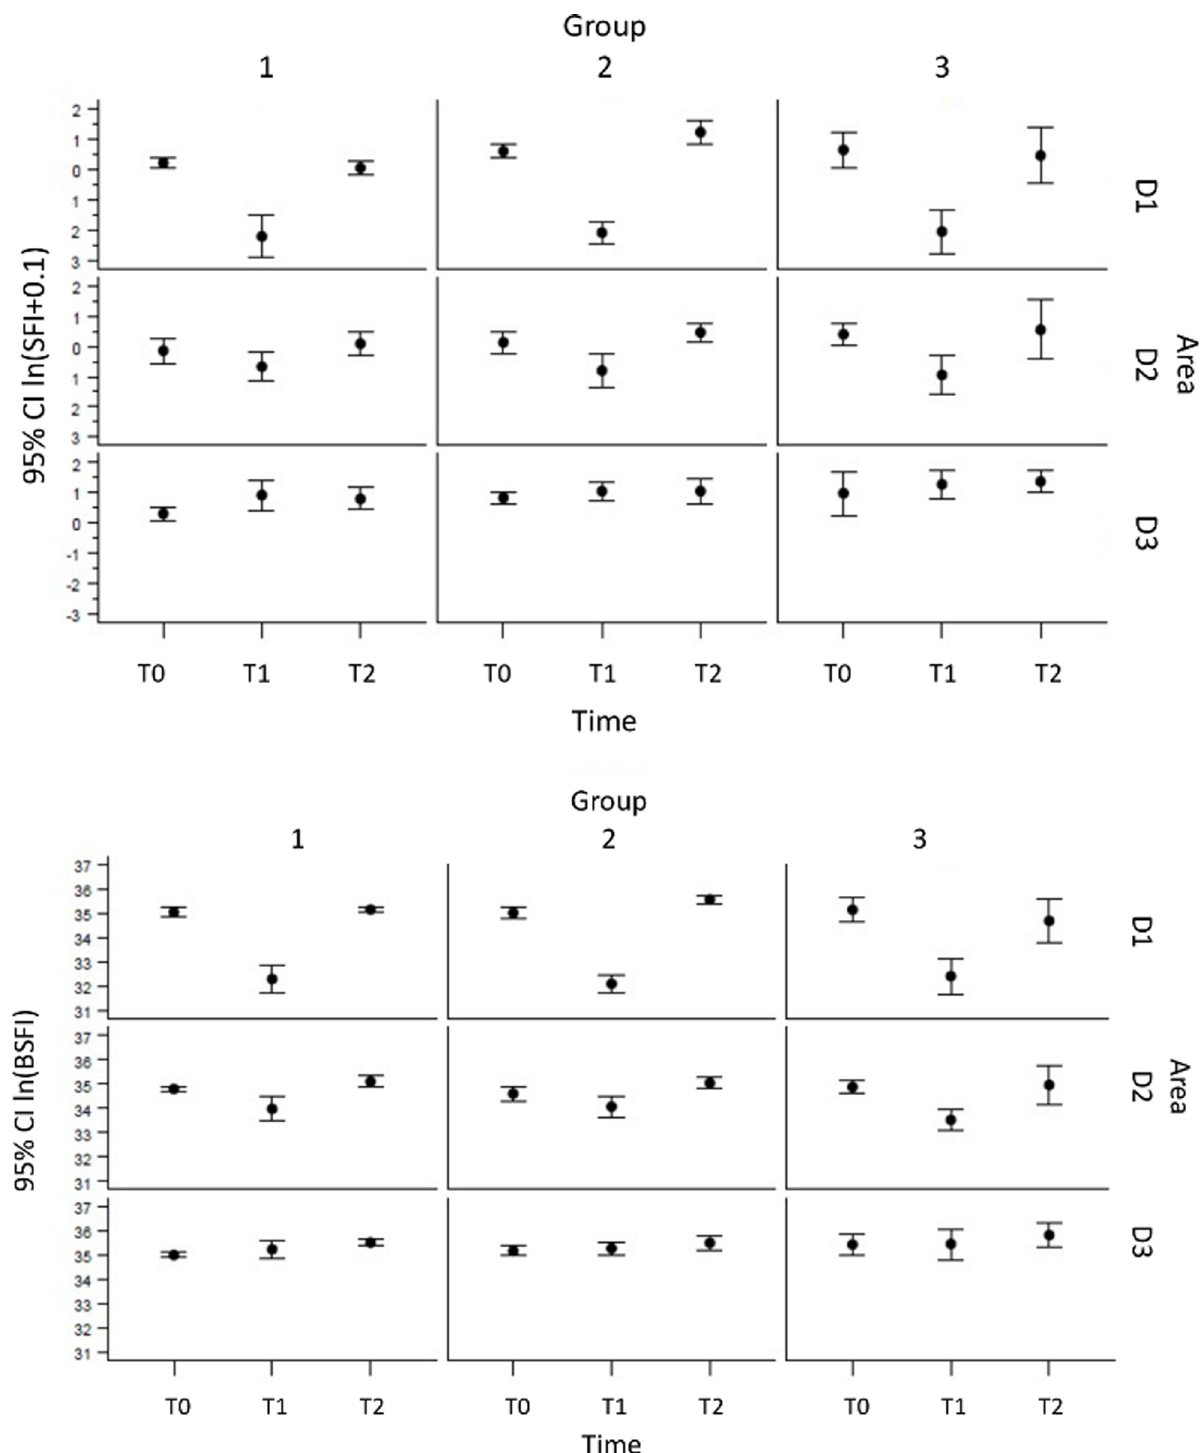
Fig 5. a. Assessment of bowel perfusion using ICG- Fluorescent imaging (ICG-FI) using Slope of Fluorescence Intensity (SFI) analysis. This parameter is represented by the maximal slope during the increase of the time-dependent fluorescence intensity induced by the first wave of the dye, which passes the capillaries of the bowel tissue. SFI showed significantly reduced perfusion in D1 (ischemic) and D2 (transitional) under Occlusion (T1) (p < 0.05) in all groups, while D3 (control) showed similar results to baseline values. After reperfusion D1 (ischemic) showed enhanced ICG-FI in all groups compared with occlusion (p < 0.05), while SFI was lowest after 3 hours of ischemia (group I), and highest after 6 hours of ischemia (group